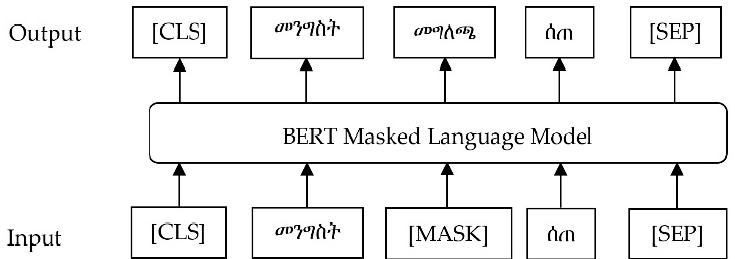
with the highest probability.